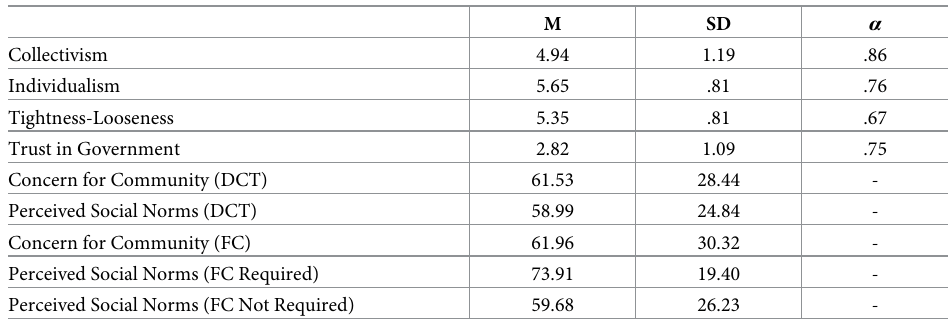
Table 2. Descriptive statistics for key